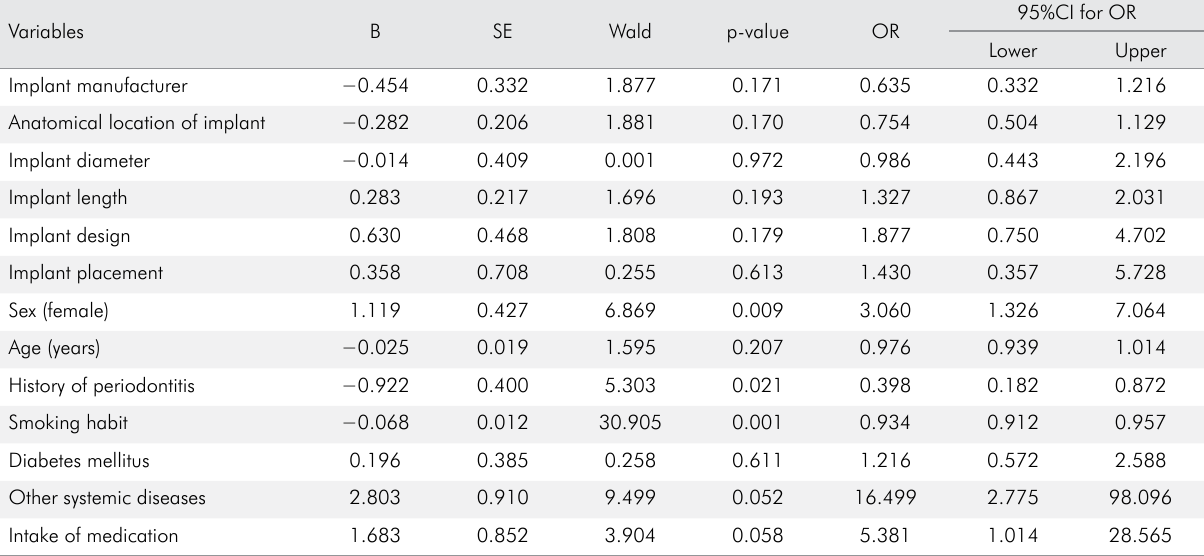
Table 5. Univariate binary logistic regression for short implant success at the implant level. Variables